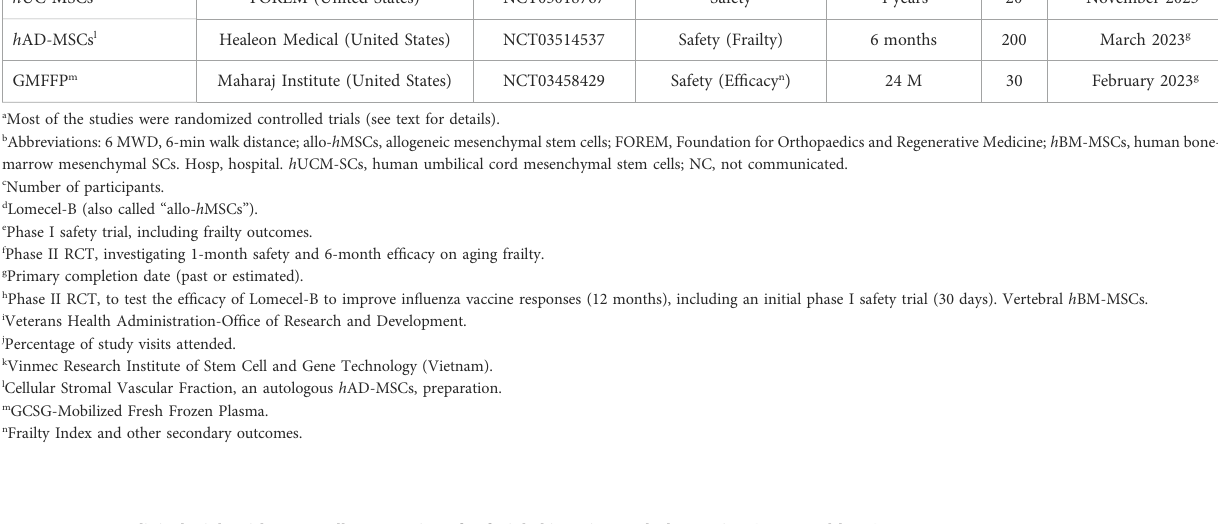
TABLE 2 Recent clinical trials with stem cell preparations for facial skin aging and photoaging (2019 and later). a